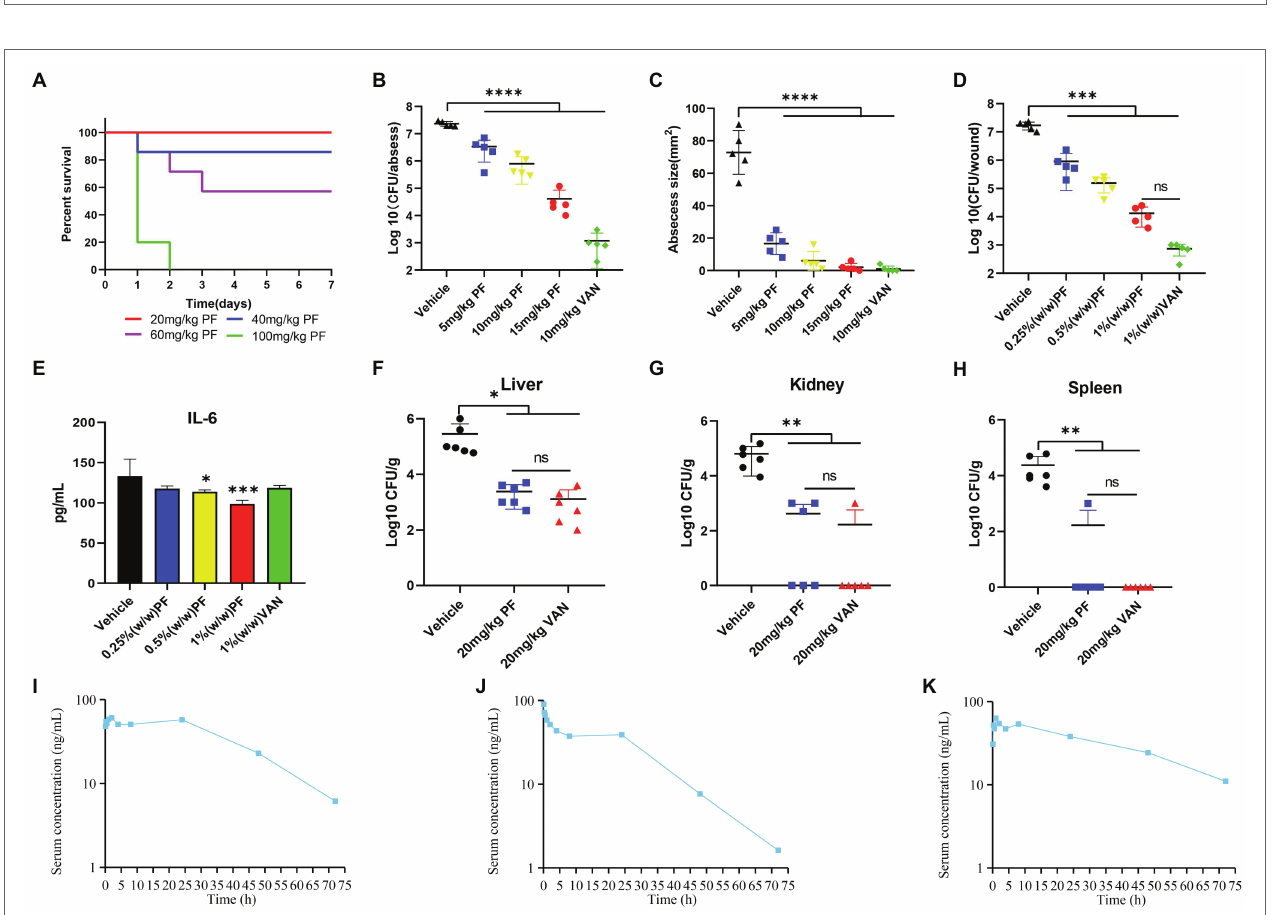
FIGURE 5 | Hemolytic activity and cytotoxicity. (A) Human blood hemolytic activity of PF, 0.2% DMSO (negative control), and 0.1% Triton X-100 (positive control). The cytotoxicity of PF to (B) A549 (C) HBE, and (D) HBMEC cell lines was determined by CCK-8 assays.